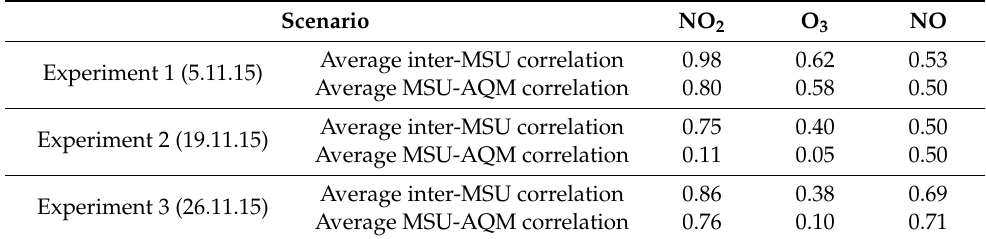
Table 8. Average node-to-node and node-to-air quality monitoring (AQM) correlations using collected personal Little Environmental Observatory (LEO) nodes data. Each experiment lasted 4 h (sampling rate 1 min). Study area: Haifa,